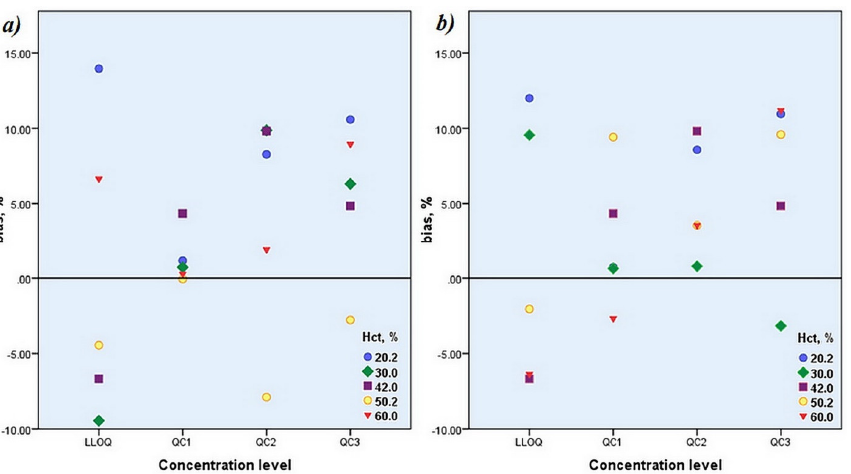
Figure 3. Relationship between% bias of calculated average concentration and nominal concentration-concentration calculated by applying regression model derived for the calibration standards with ( a ) appropriate Hct and ( b ) nominal Hct.